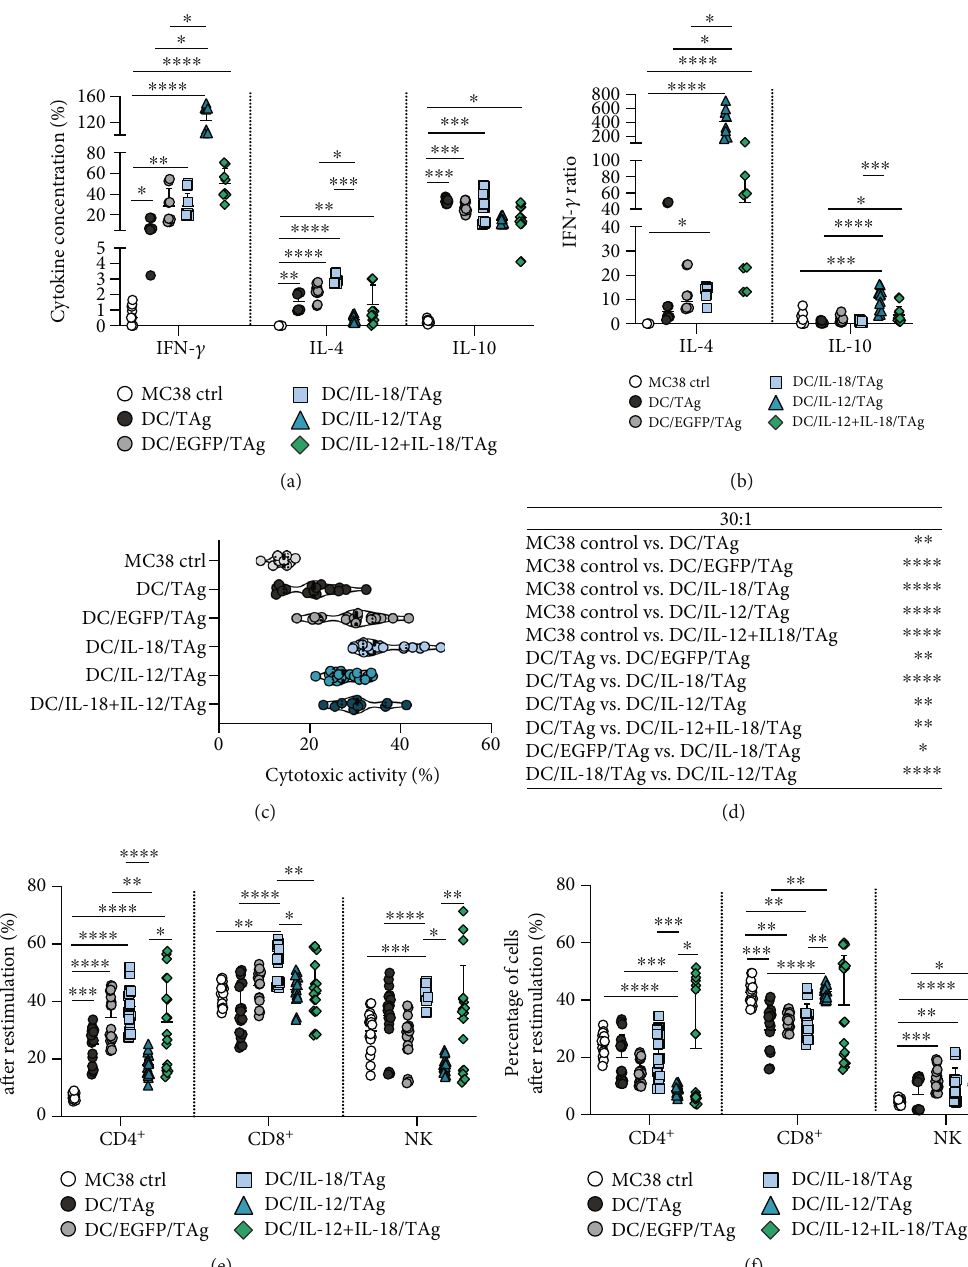
Figure 10: E ff ect of administration of transduced DCs on induction of antitumor response in the spleen on the 7th day after injection. (a) Cytokine concentration (IFN- γ , IL-4, IL-10) in supernatants after restimulation of spleen cells with MC38 cells. (b) Ratio of IFN- γ and IL-4 or IL-10 concentration in supernatants after restimulation. (c, d) Cytotoxic activity of splenocytes (e ff ector cells) against DiO + MC38 cells (target cells). (e) Percentage of CD107a + cells among CD4 + , CD8 + , and NK cells measured by CD107a degranulation assay. (f) Percentage of CD4 + , CD8 + , and NK cells among splenocytes after restimulation. Results are presented as mean ± SD calculated for 5-6 mice per group. Di ff erences between groups were estimated using the nonparametric Kruskal-Wallis test followed by Dunn ’ s multiple comparison post hoc test or the parametric Brown-Forsythe and Welch ANOVA test followed by Dunnett ’ s T3 multiple comparison post hoc test ( ∗ p < 0 : 05 , ∗∗ p < 0 : 01 , ∗∗∗ p < 0 : 001 , ∗∗∗∗ p < 0 : 0001